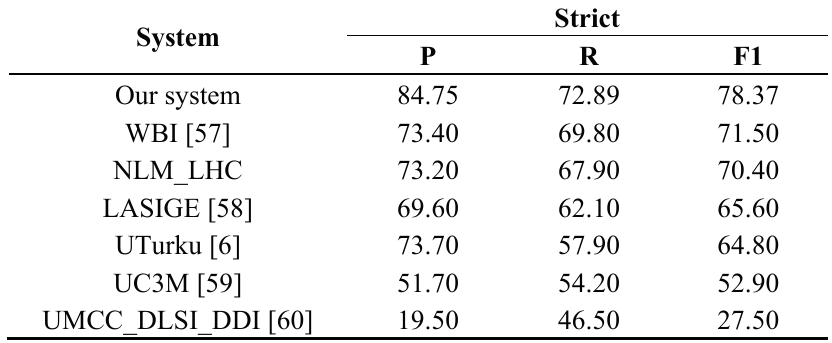
Table 3. Performance comparison between our system and systems of DDIExtraction 2013 (%).